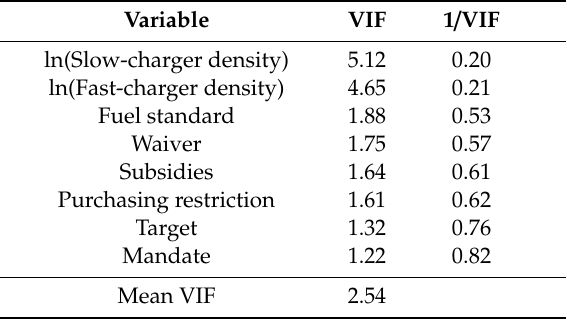
Table 6. Results of variance inflation factor.